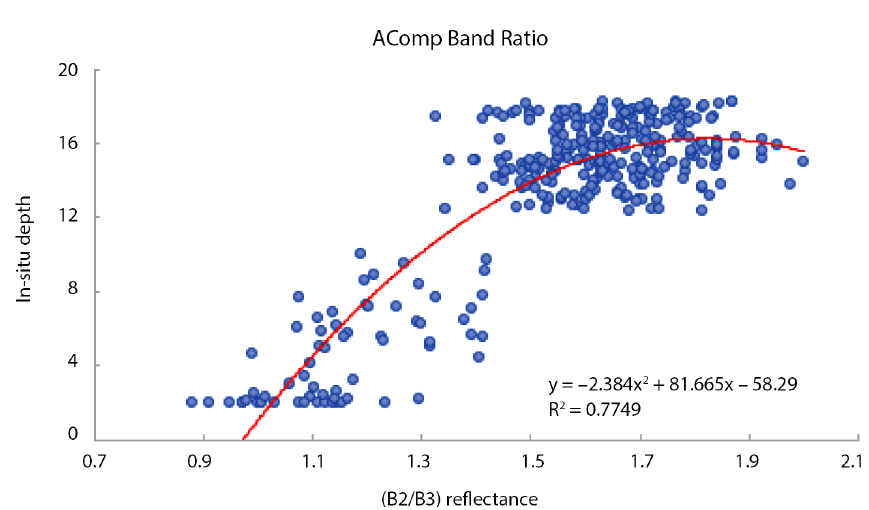
Figure 5. Second-order polynomial model of blue and green band ratio from AComp